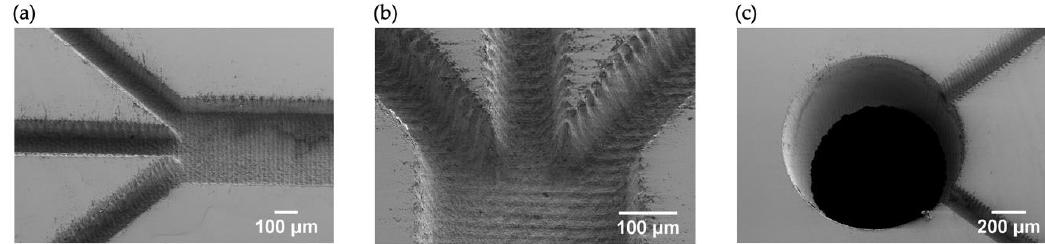
Figure 5. ( a , b ) SEM images of the microfluidic channel. ( c ) SEM image of the outlet hole.